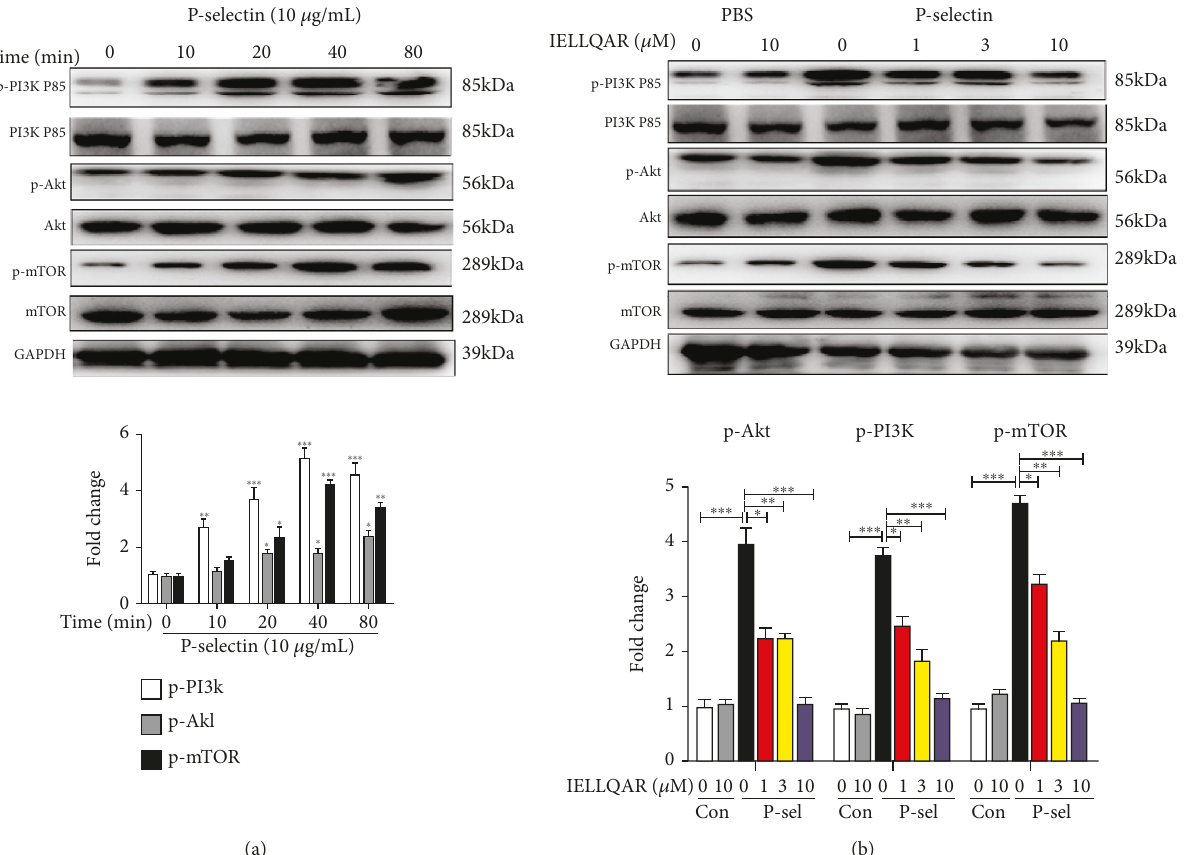
Figure 7: (a, b) IELLQAR inhibited monocyte activation by P-selectin-dependent activation of the PI3K/Akt/mTOR pathways. PBMCs were treated as described in Figure 6, and the expression levels of total and phosphorylated PI3K P85, Akt, and mTOR were determined by Western blot. Data are presented as the mean ± SEM ( n = 3 ). ∗ p < 0 05 , ∗∗ p < 0 01 , and ∗∗∗ p < 0 001